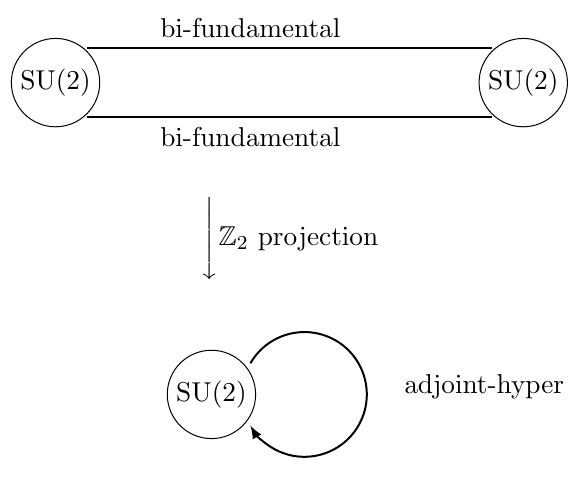
Figure 1 . Z 2 projection of the SU (2) (cid:2) SU (2) gauge